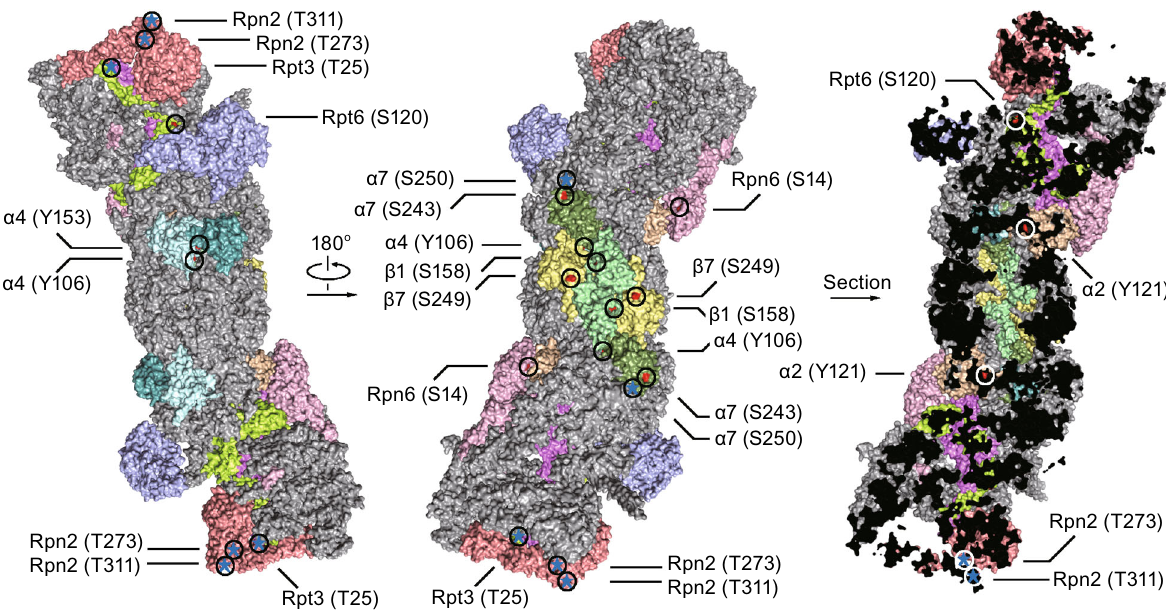
Figure 1. Structural view of a selection of human 26S proteasome phosphosites. Surface (left, middle) and sectional (right) views of human 26S proteasome (gray) are shown based on high-resolution cryo-EM structures (PDB 5GJR). Phosphosites of subunits Rpt6 (lemon), Rpn6 (light pink), α 7 (smudge), Rpt3 (violet), Rpn2 (salmon), α 4 (pale cyan), α 2 (wheat), β 7 (pale yellow), β 1 (pale green) are marked with circles. Sites visible from available structures are highlighted in red, while predicted positions of invisible sites are represented with a blue